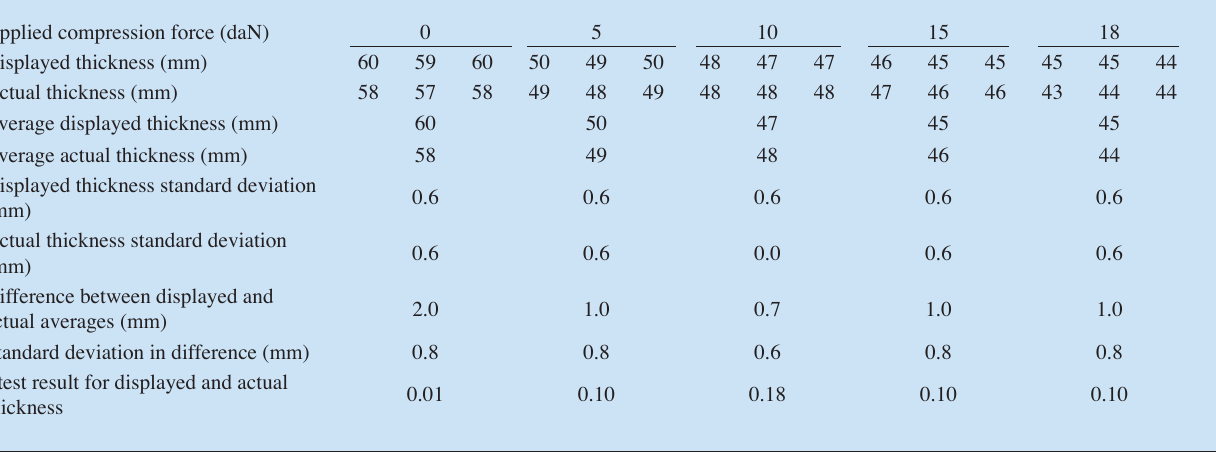
Table I. Superflab thickness accuracy and reproducibility at different compression forces